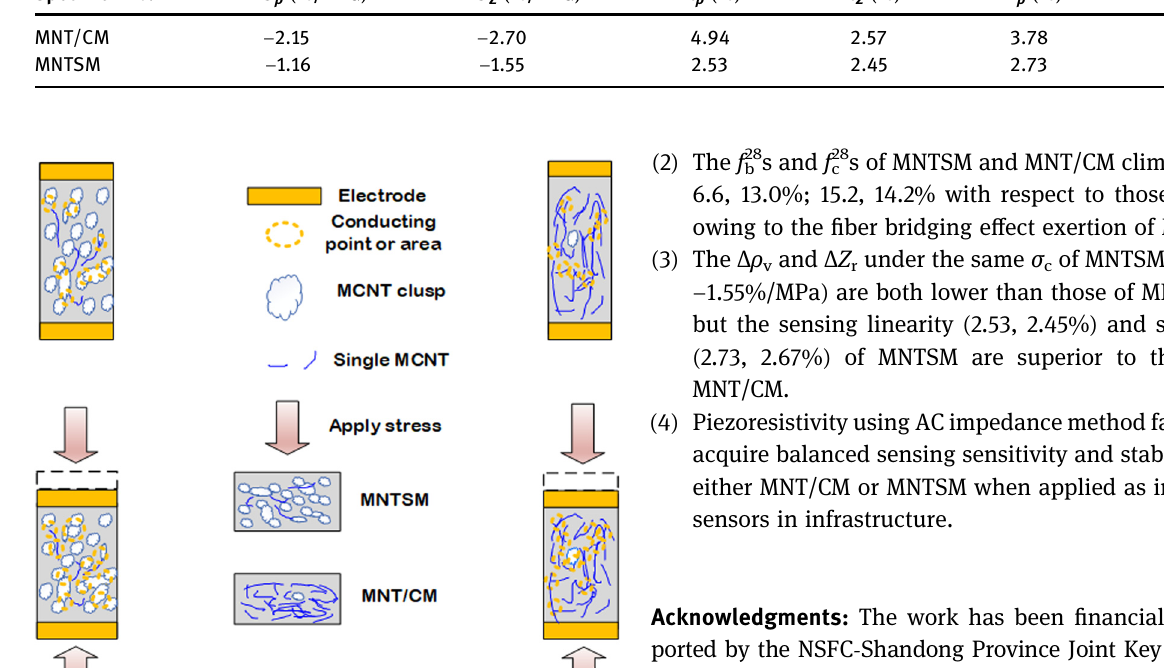
Table 3: Piezoresistive sensing parameters of MNT/CM and MNTSM Specimen no.